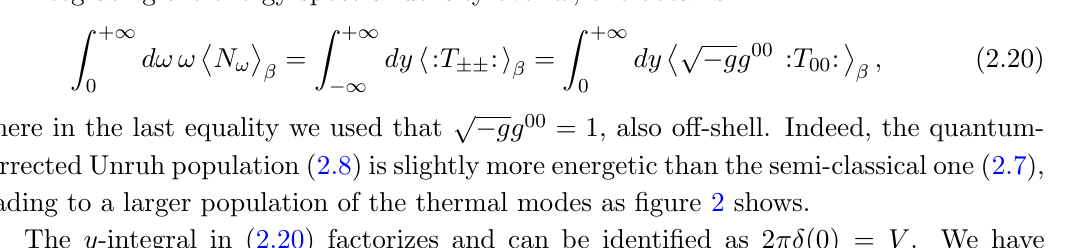
Figure 2 . Blue (upper): exact energy spectral density ! h N ! i from (2.19)with (cid:12) = 2. Red (lower): semi-classical Planck black body spectrum of Unruh radiation, coming from